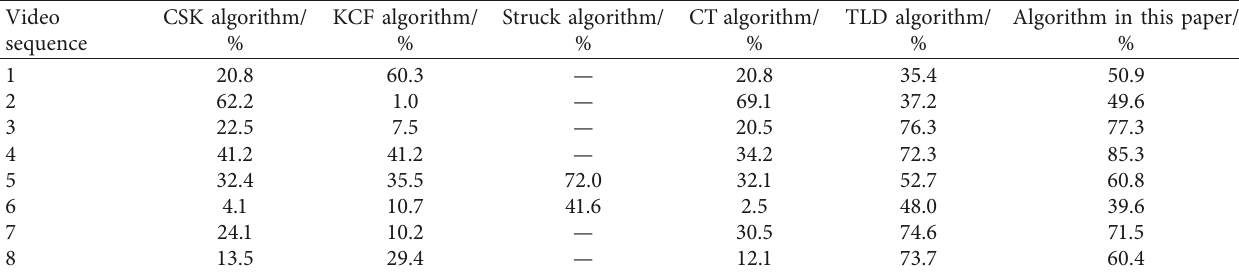
Table 4: Average coverage of different algorithms